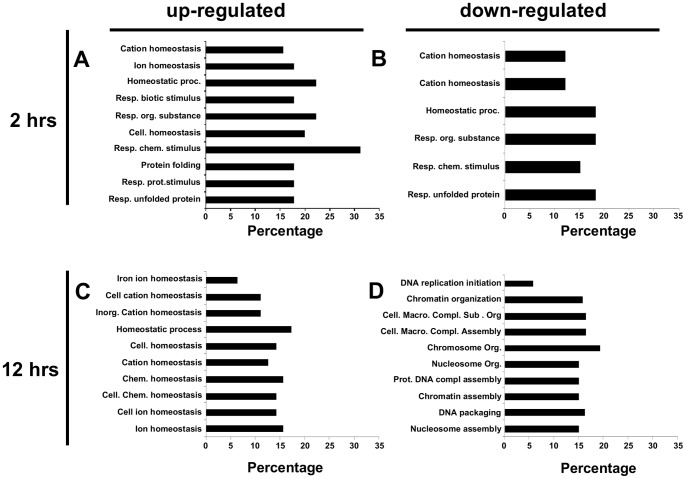
Biological processes altered by iAs exposure.Most significant Gene Ontology (GO) terms associated with gene expression up-regulation (A–C) and down-regulation (B–D) after 2 (A, B) and 12 hrs (C, D) of exposure to 5 µM of iAs. All selected categories showed a p<0.001.